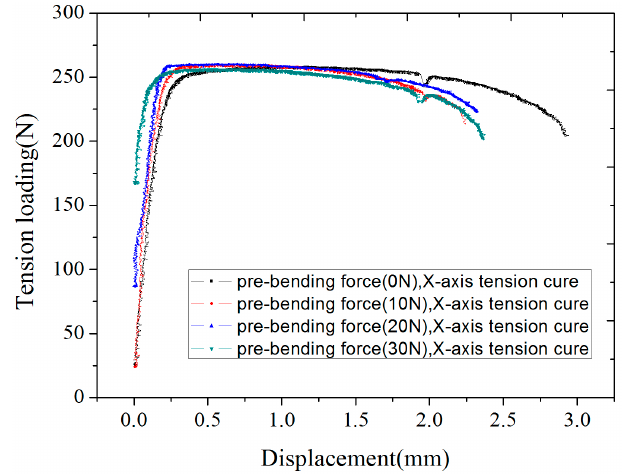
Figure 12. X-axis tension curves under different bending loading.